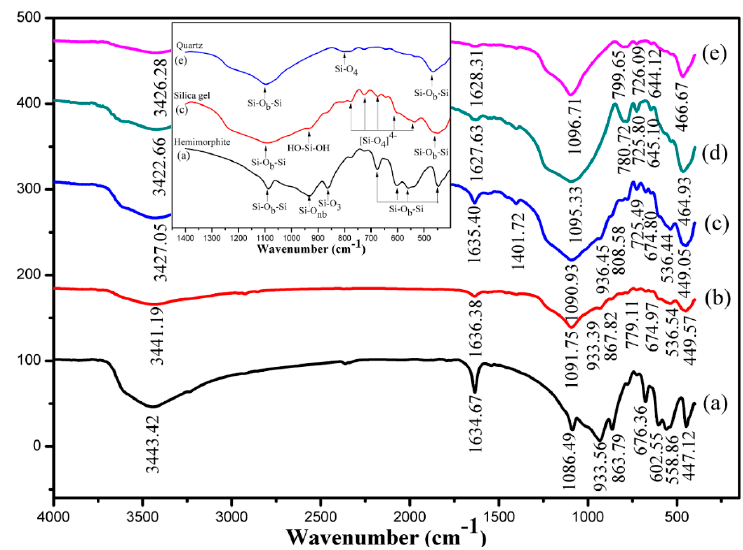
Figure 13. Fourier transform infrared (FT ‐ IR) spectra of the hemimorphite and the residues. ( a ) Hemimorphite; ( b ) 75 °C; ( c ) 80 °C; ( d ) 100 °C; and ( e ) 108 °C. Based on the above analysis, silica gel was generated at temperatures of 75–90 °C and decomposed into silica at temperatures of 95–108 °C. The silica gel is produced and adsorbed on the surface ‐ active sites of the hemimorphite particles. This is the reason for the high apparent activation